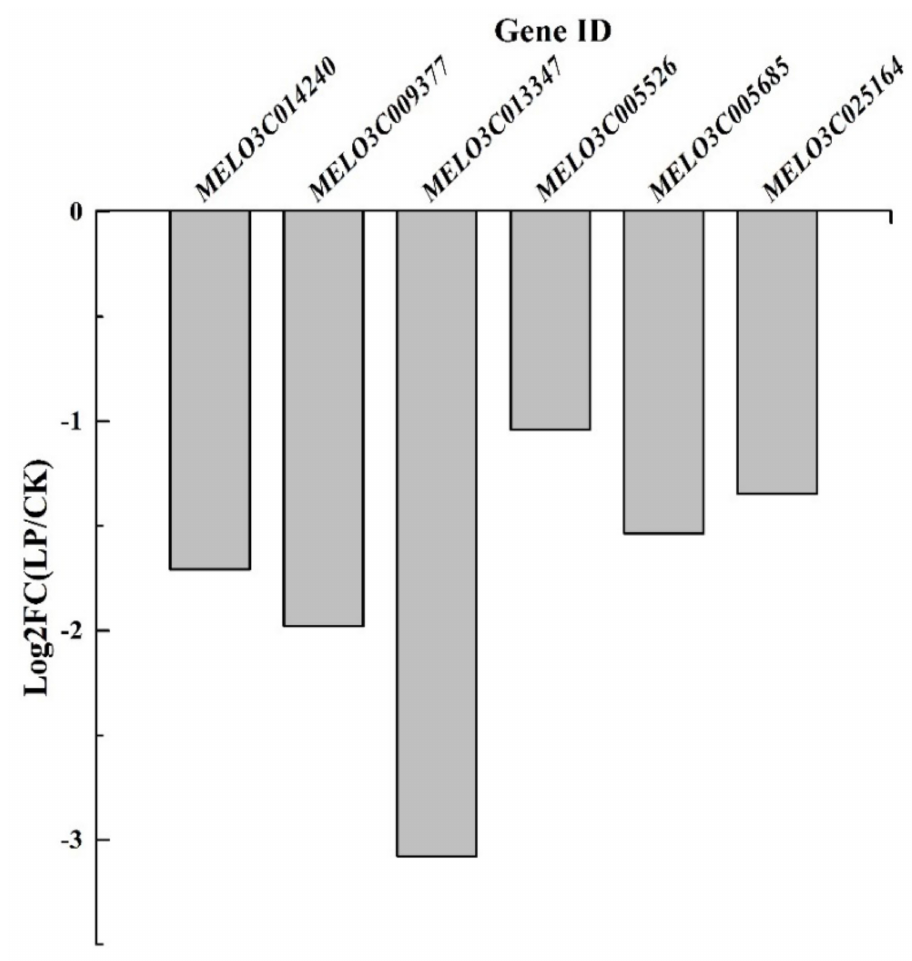
Figure 9. The log 2 (fold change) of the aquaporin genes at the transcriptional